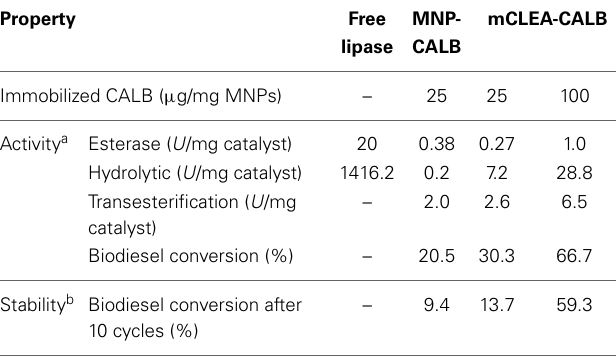
Table 2 | Main properties of magnetic biocatalysts obtained of